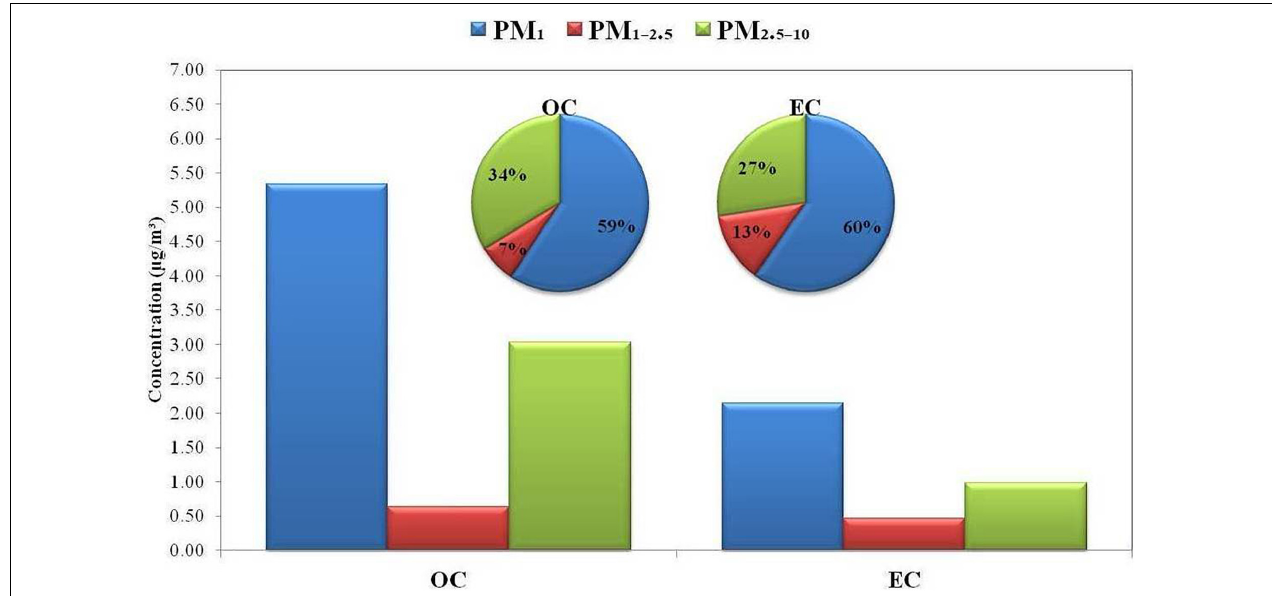
FIGURE 4 | Size distributions and contributions of the carbonaceous